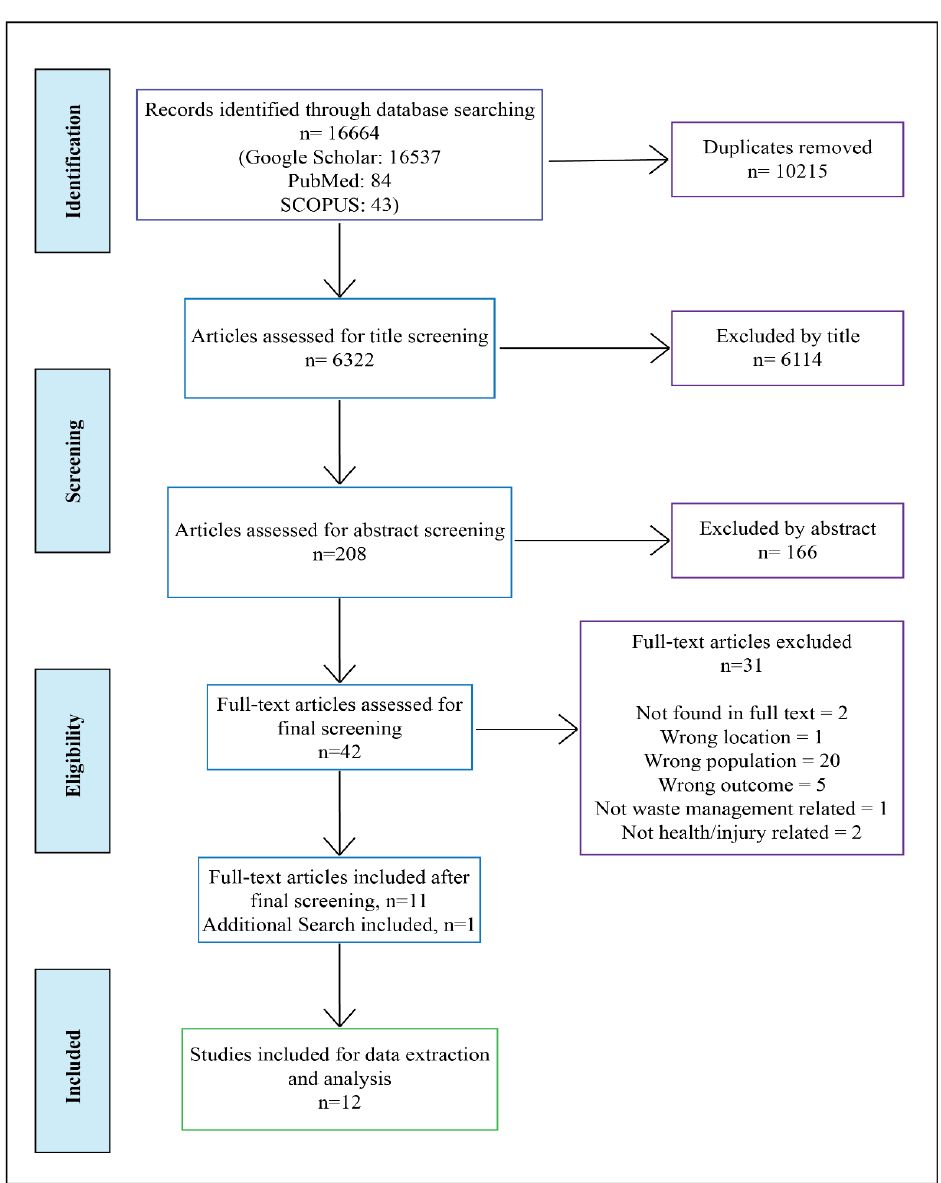
Figure 1. PRISMA flow diagram for searching and selecting journal articles.